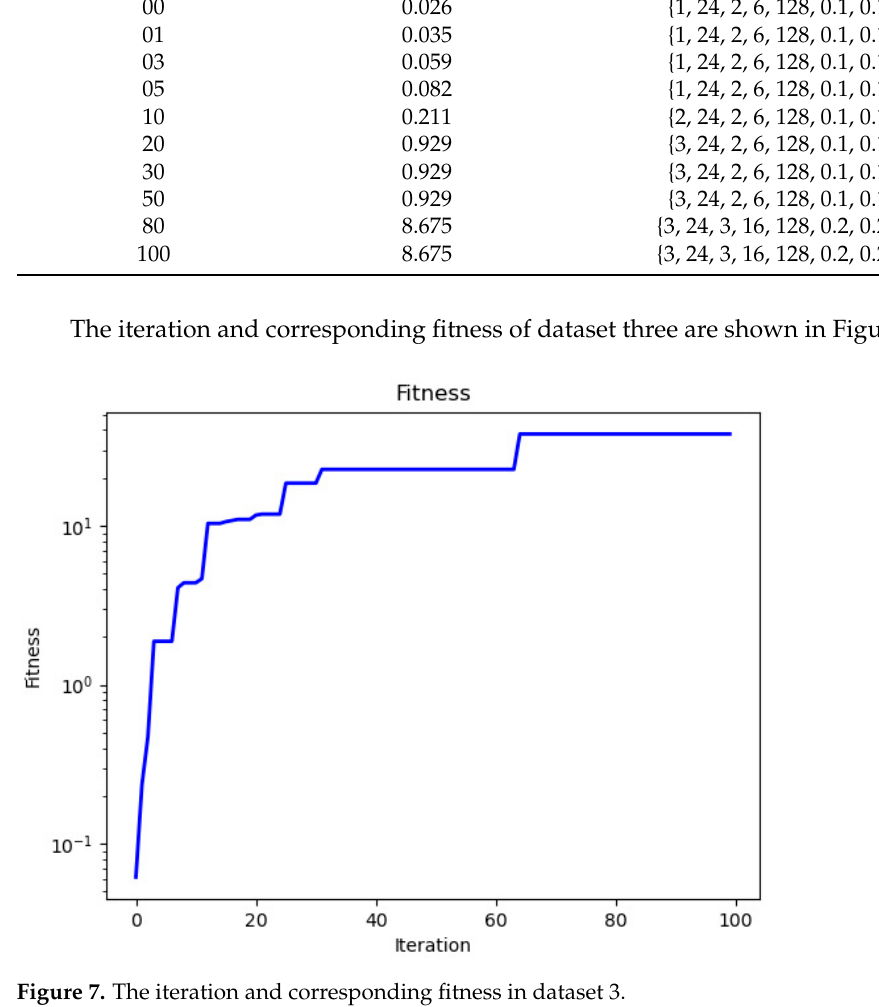
Figure 7. The iteration and corresponding fi tness in dataset 3.